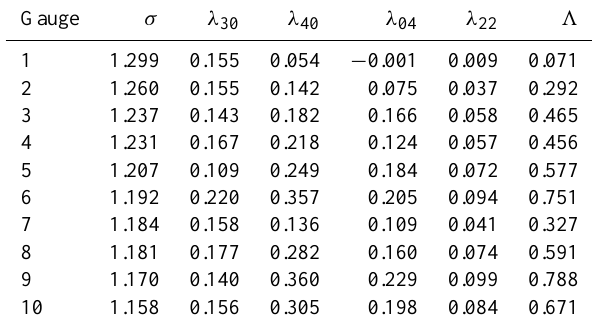
Table 5. Overall statistical averages from 15min segments for 8230: H s =3.6/3.6m, T p =7/14s.